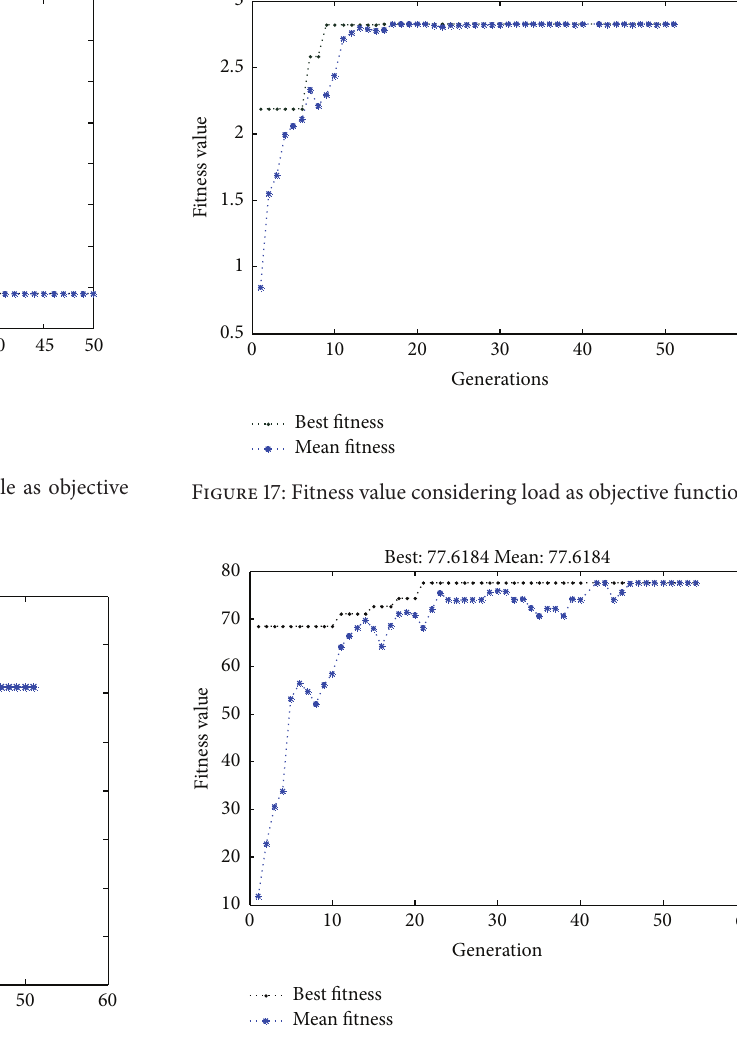
Figure 18: Fitness value considering mass parameter as objective function.